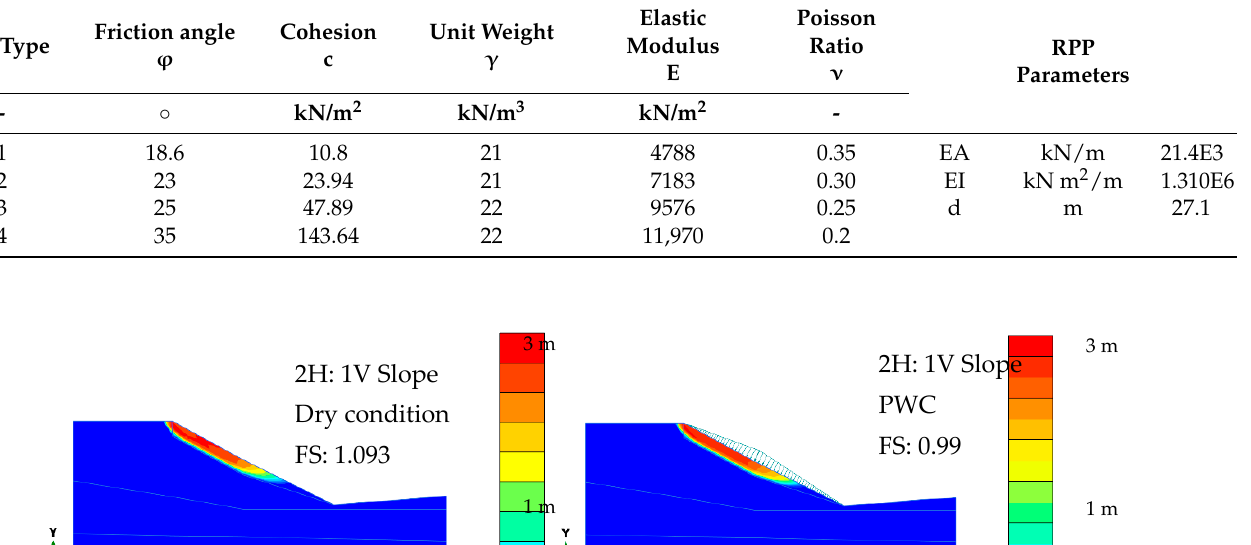
Table 1. Parameters from the FE analysis.